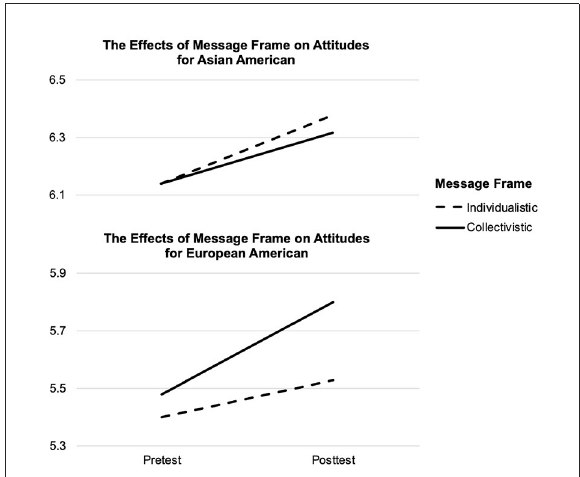
FIGURE1 The effects of message frame on attitudes by ethnicity.